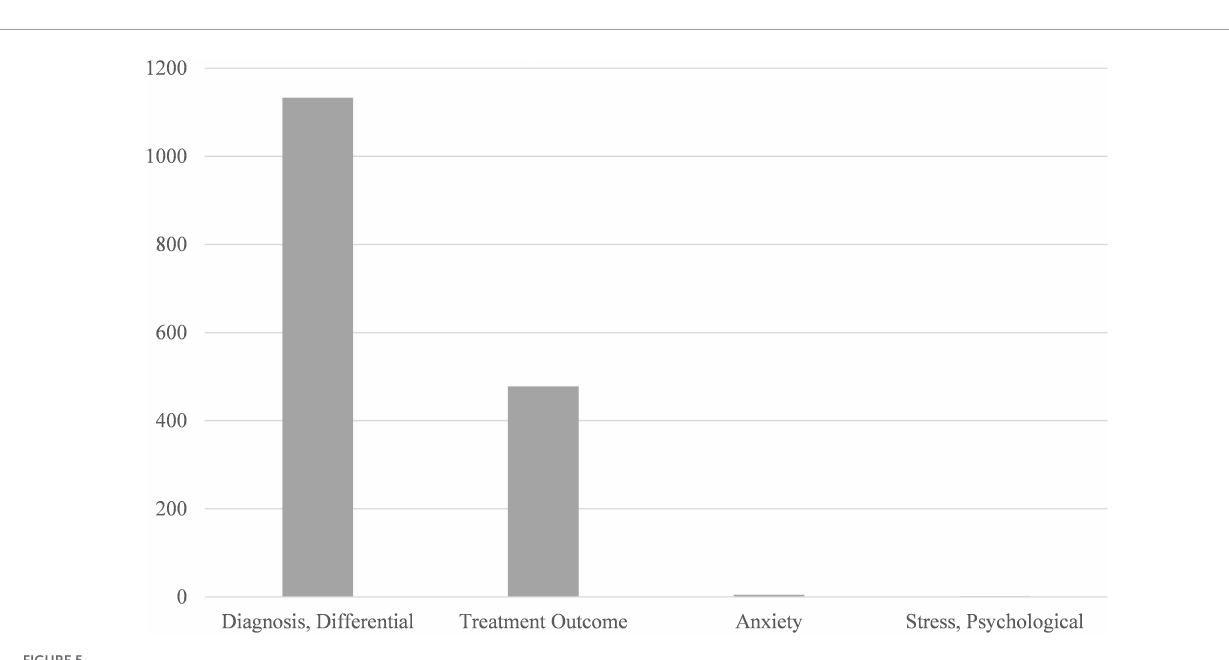
is caused by a critical stage in the diagnosis and treatment of thyroid